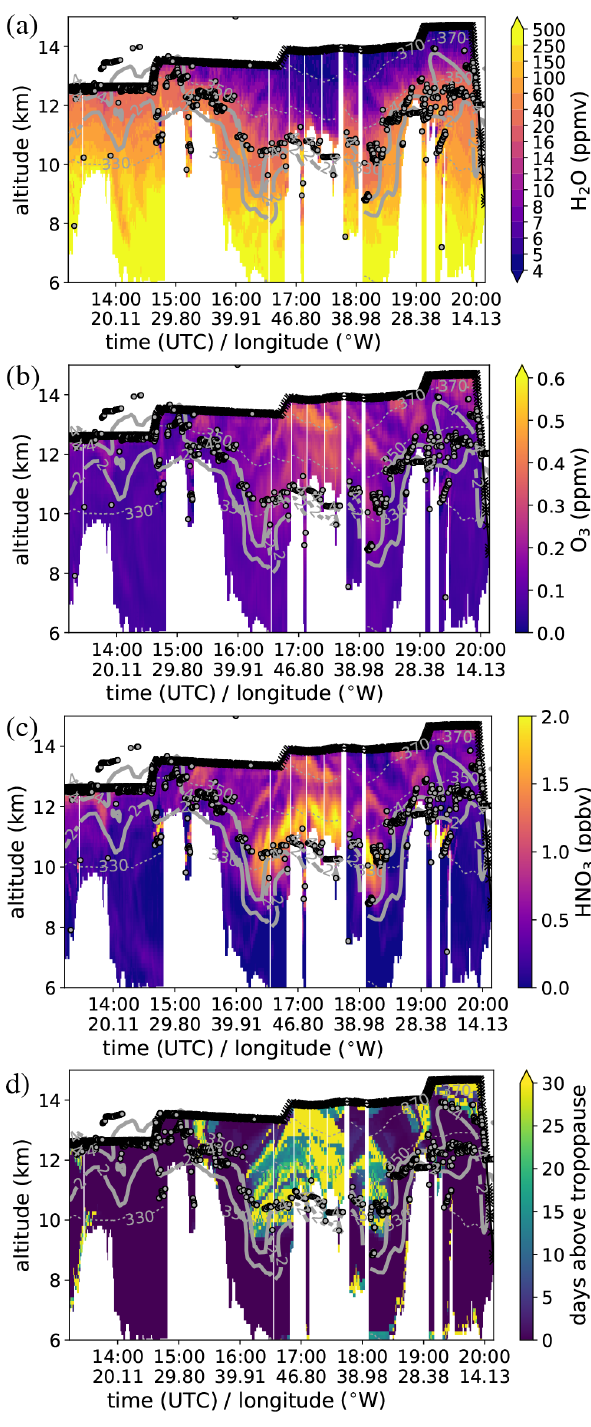
Figure 2. (a–c) 7 October H 2 O, O 3 and HNO 3 2-D GLORIA data along the flight path in Fig. 1a. (d) Stratosphere residence time (yel- low for ≥ 30d). Isentropes – dashed lines; 2 and 4PVU contours – thick solid lines; thermal tropopause –